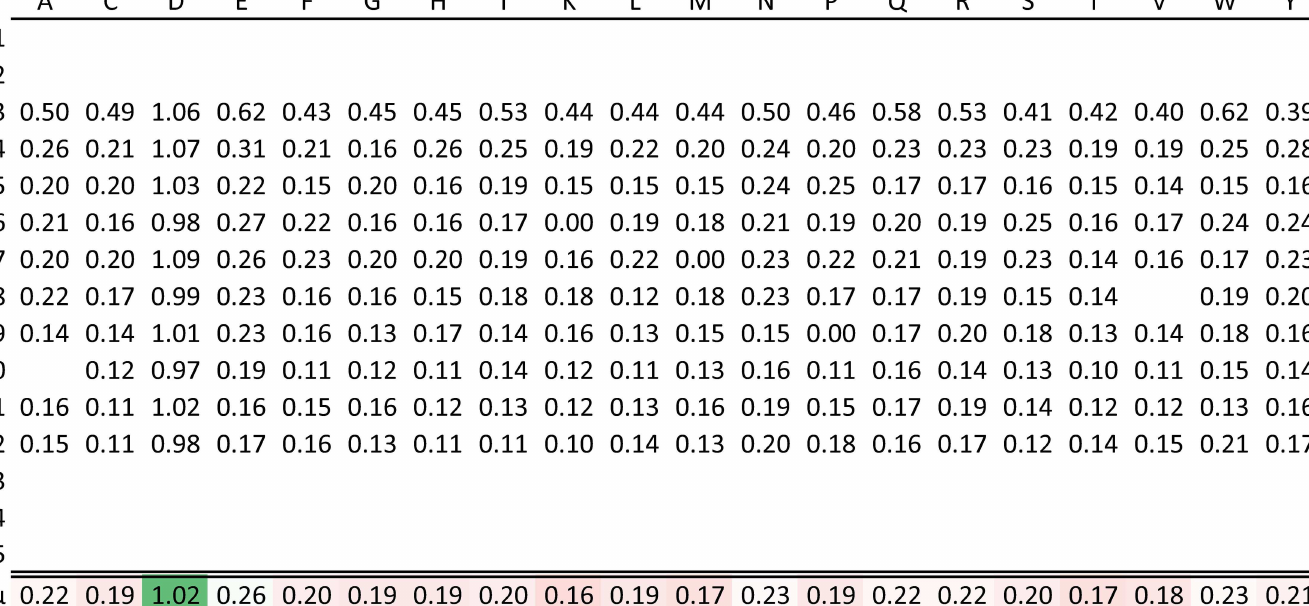
PLOS ONE | DOI:10.1371/journal.pone.0168453 January17,